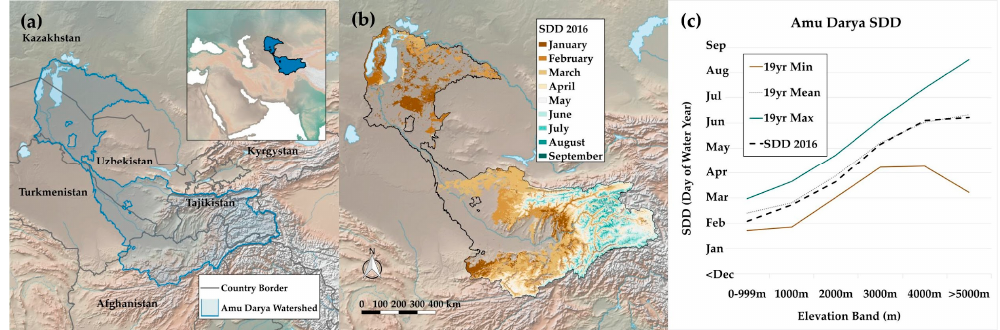
Figure 7. ( a ) The Amu Darya Basin (ADB) transboundary map with country boundaries. ( b ) The WY2016 snow disappearance date (SDD) map of the ADB watershed at 500 m resolution generated from the SnowCloudMetrics portal. ( c ) The 19-year maximum, 19-year minimum, and 19-year mean SDD values for the ADB, spatially averaged and binned by elevation band plotted with the WY2016 SDD dataset.